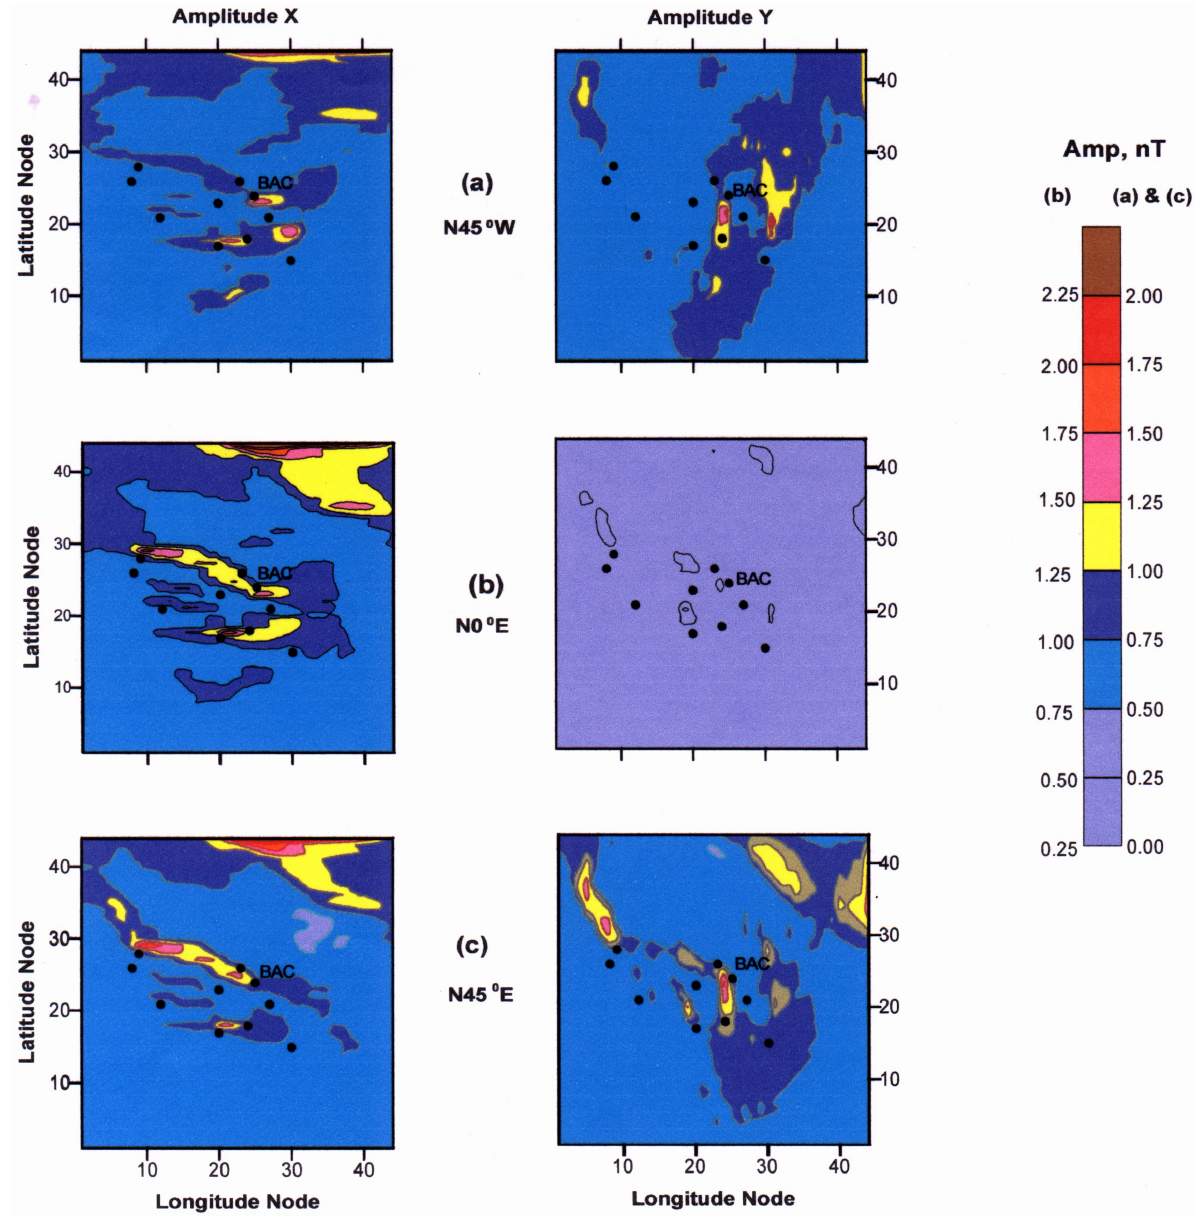
Fig. 6. Contour plots of X and Y amplitudes resulting from electromagnetic induction in laterally variable conductivity distribution map, shown in Fig. 2. Electromagnetic responses are computed for a oscillating source field of period 10 min and amplitude of 1 nT. Contour plots are shown separately when uniform source field is linearly polarized in (a) N 45 ◦ W (b) N-S and (c) N 45 ◦ E